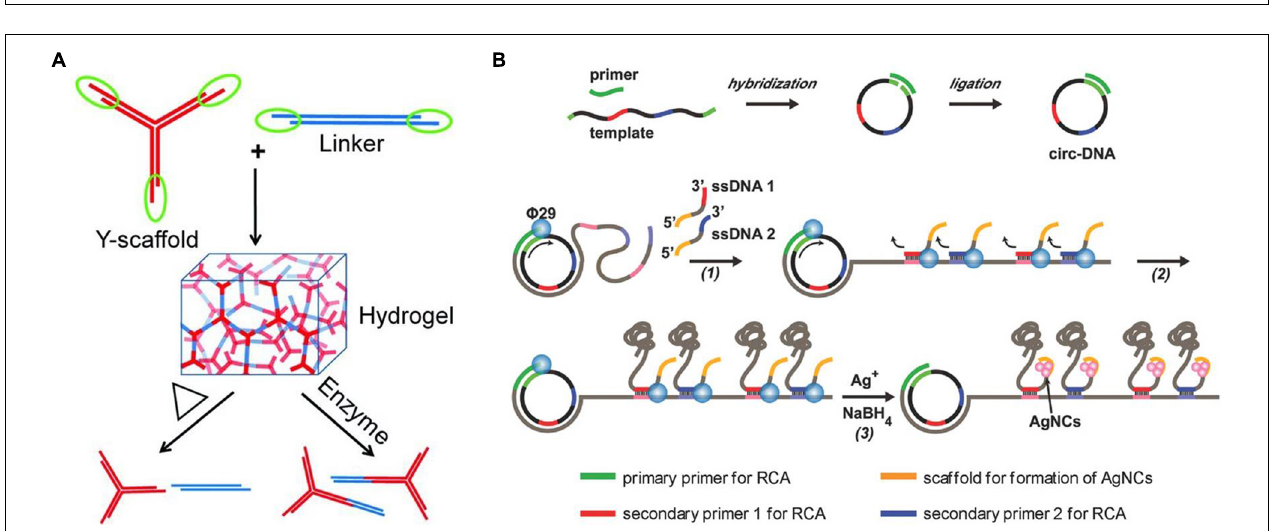
FIGURE 1 | Schematic diagram of the development, preparation, and biomedical applications of DNA-based hydrogels.